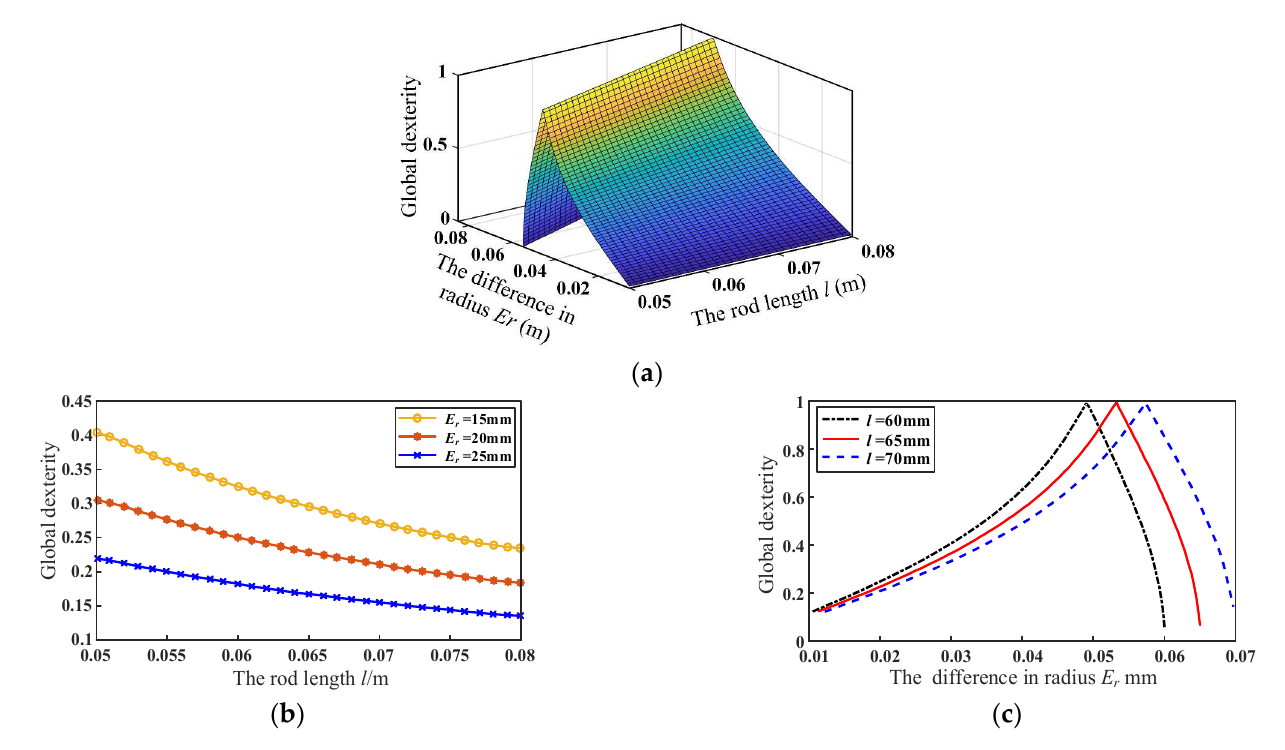
Figure 5. Relationship between scale parameters and global dexterity: ( a ) the effect of rod length l and radius difference E r on global dexterity; ( b ) the effect of rod length l on global dexterity; ( c ) the effect of radius difference E r on global dexterity.